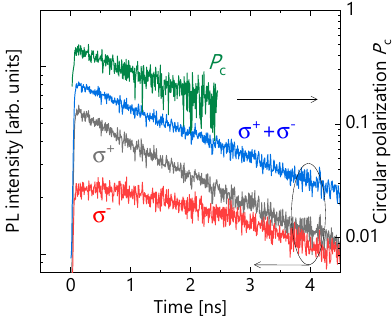
Figure 1. Typical results of polarization- and time-resolved photoluminescence (PL) decay signal for the sample grown at growth temperatures ( T g ) of 432 °C measured at room temperature (RT). Circular polarization ( P c ) is given by ( I σ + − I σ − ) / ( I σ + + I σ − ) , where I σ + and I σ − represent right- and left-circularly polarized PL components under σ + excitation, respectively.